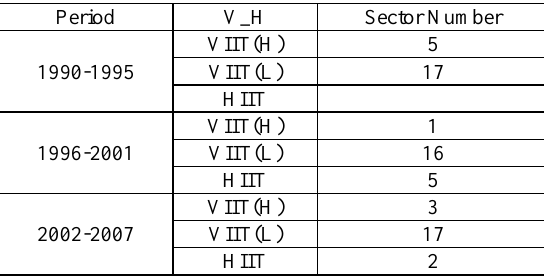
Table 7: Number of Sectors